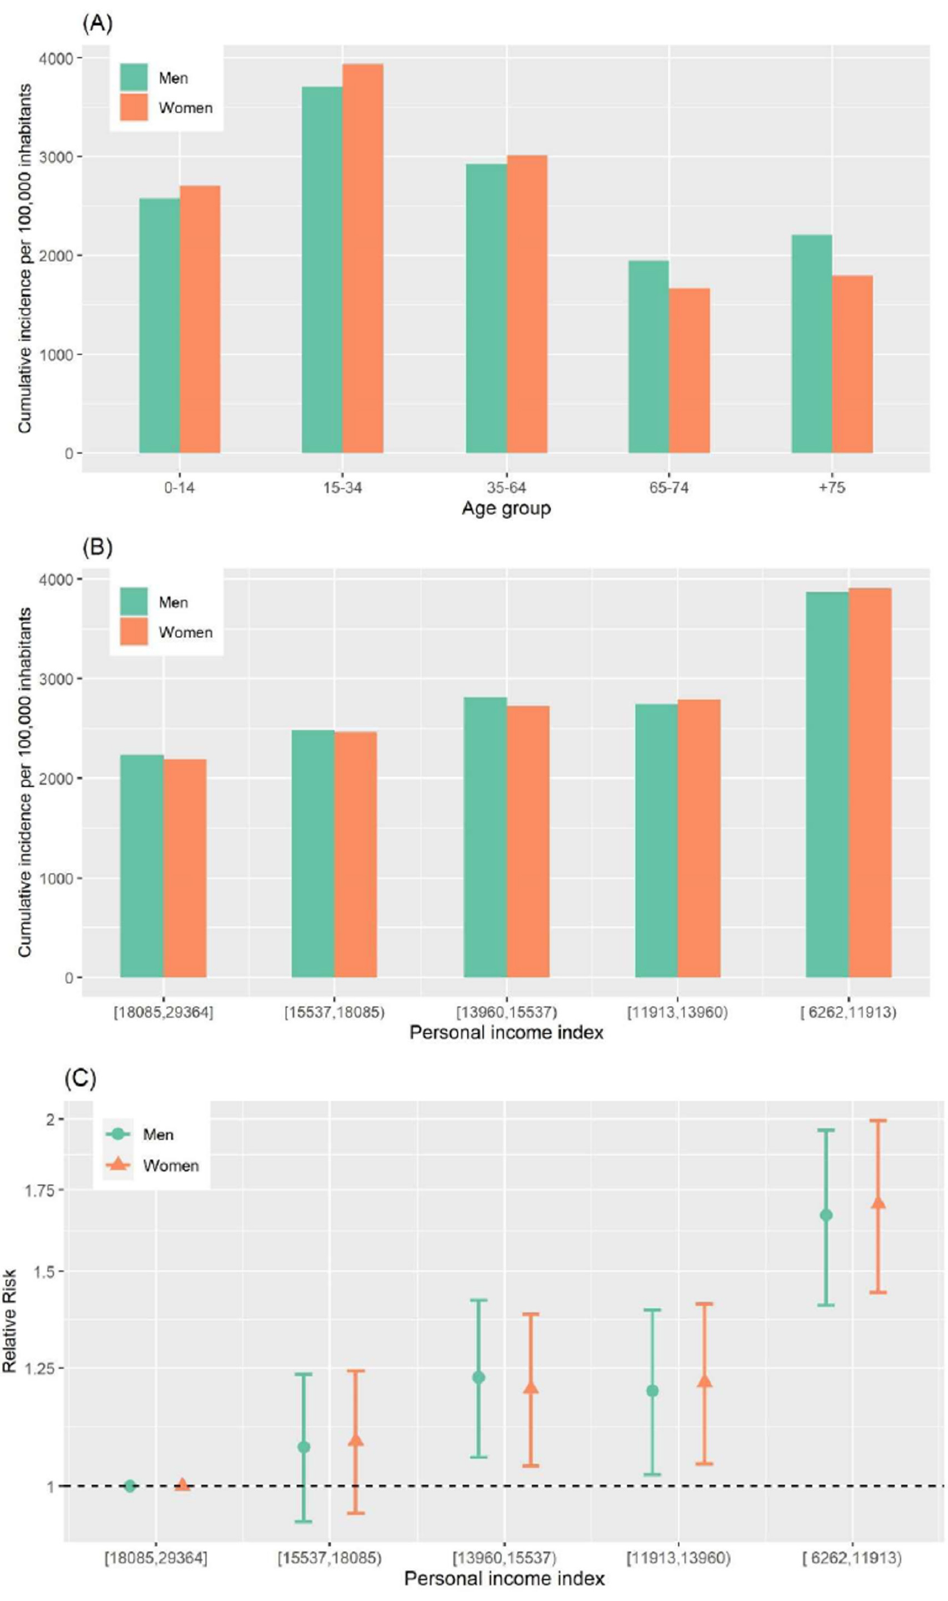
Figure 3. ( A ) Cumulative incidence of COVID-19 per 100,000 inhabitants for each age group and sex; ( B ) Cumulative incidence of COVID-19 per 100,000 inhabitants for each income group (based on personal income index in Euros) and sex; ( C ) Relative risk for each income group and sex. Period from 16 July to 30 November 2020 in Barcelona